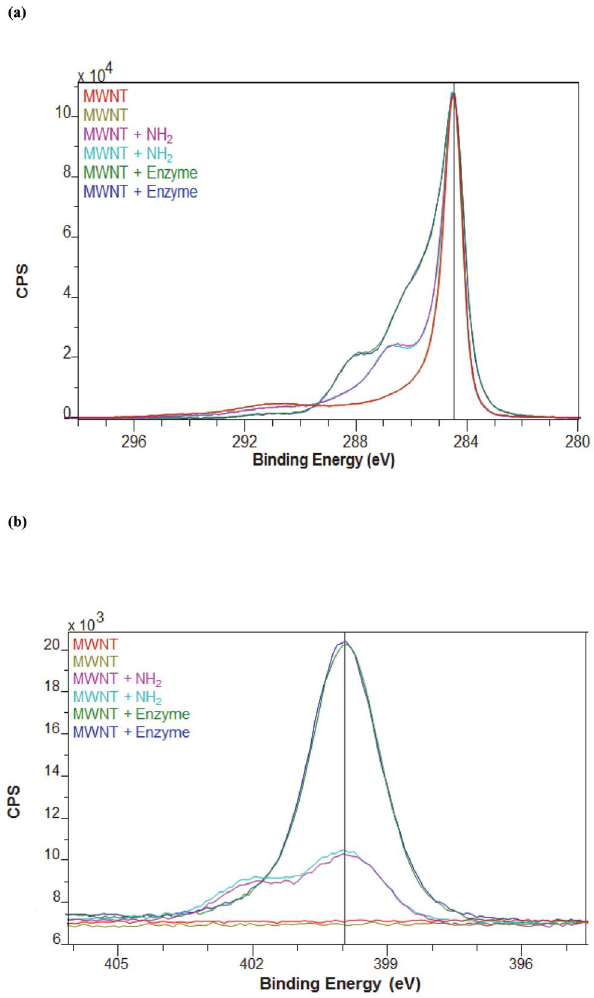
Figure 4. a) XPS spectrum of MWNT and MWNT bound lipase showing carbon 1 s high resolution spectra. b) XPS spectrum of MWNT and MWNT bound lipase showing nitrogen 1 s high resolution